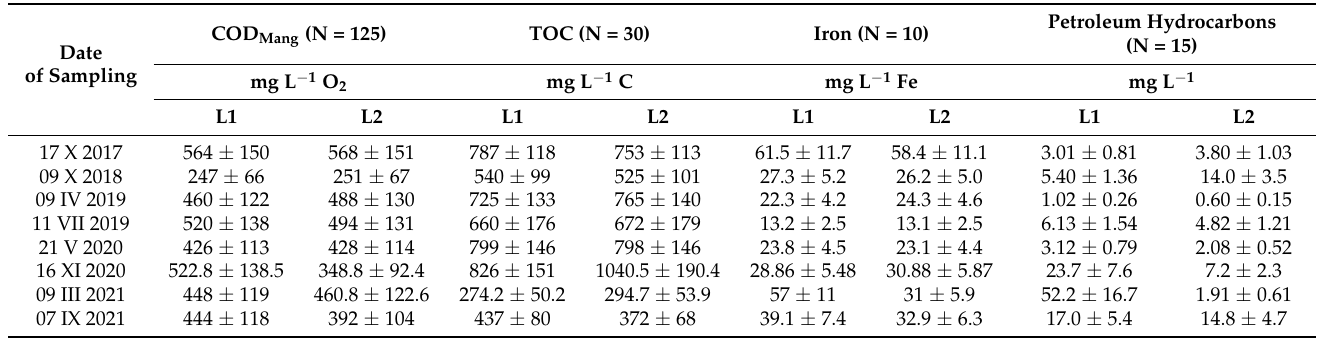
Table 1. Summary of the most important results for 2017–2021 from the study of leachate from the Zgierz landfill based on the reports supported by the Voivodeship Inspectorate of Environmental Protection in Ł ó d´z (Poland) of 07 XI